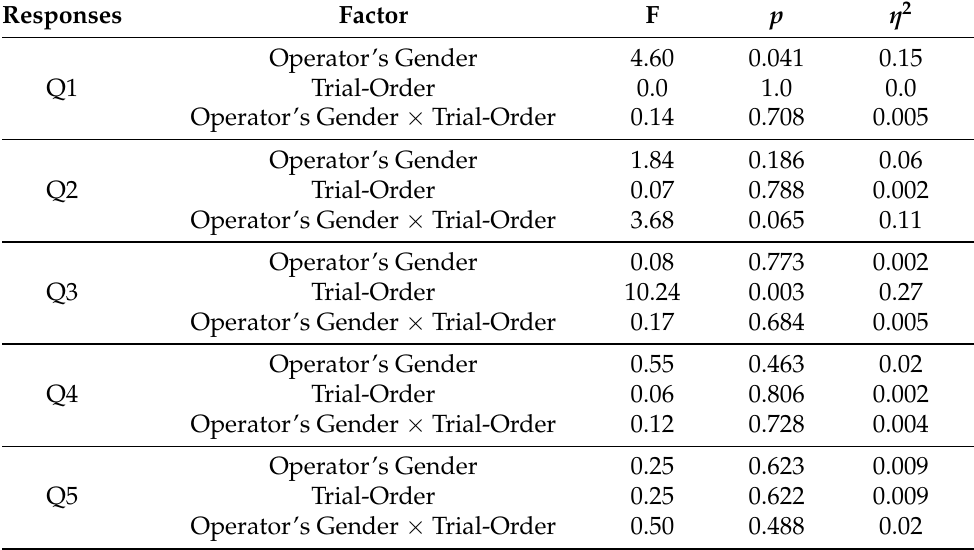
Table 1. GLM: Effect of experiment’s design factors (i.e., operator’s gender, trial-order, and their interaction) on participants’ responses to Q1 through Q5. In this table, “Operator’s Gender” refers to the supposed gender of operator in (sham) human-controlled